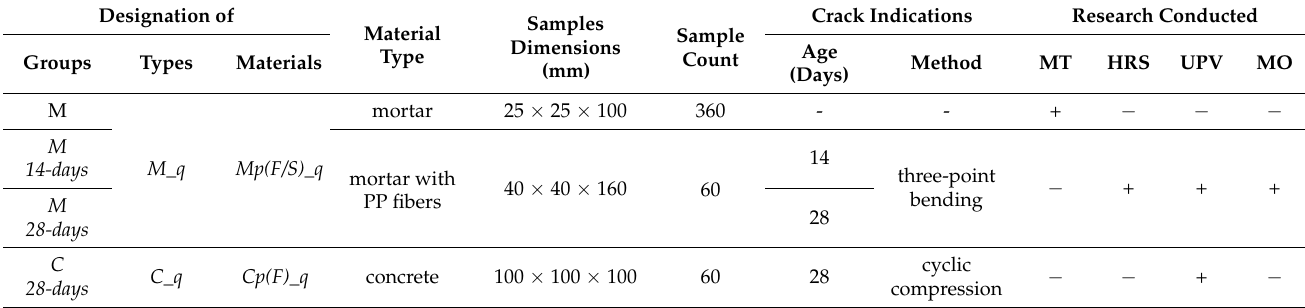
Table 1. Summary of key information regarding study groups and the research